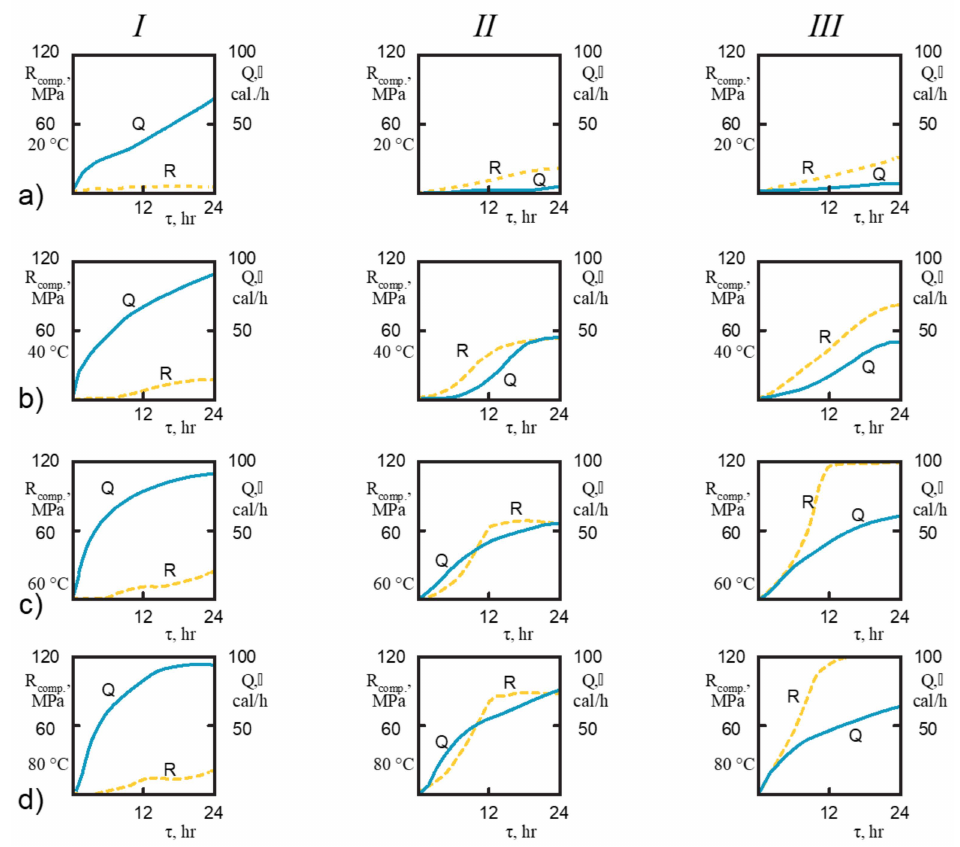
Figure 9. Heat release Q and compressive strength R comp of the cements:( a ) t = 20 ◦ C; ( b ) t = 40 ◦ C; ( c ) t = 60 ◦ C; ( d ) t = 80 ◦ C.